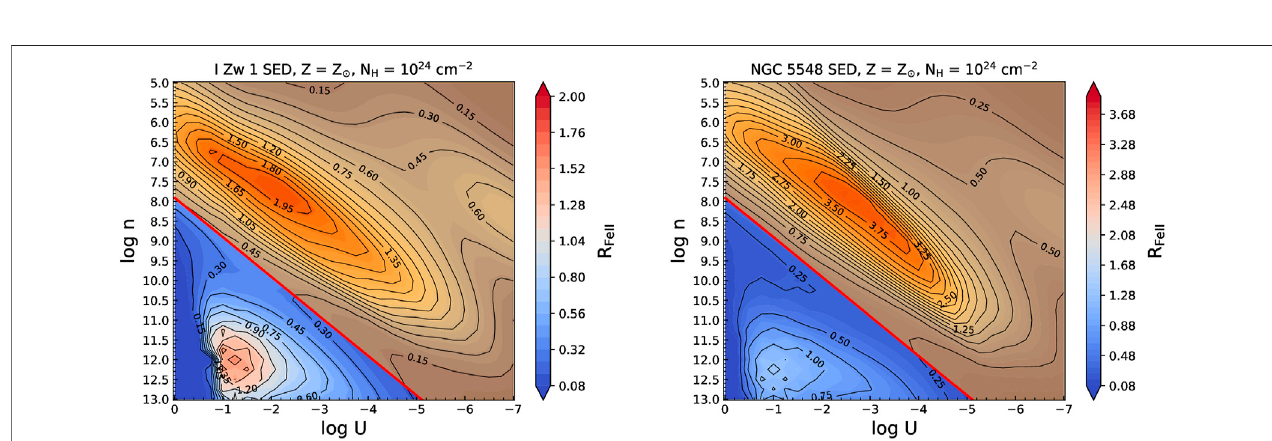
FIGURE 3 | log U − log n H 2D histograms color-weighted by R FeII . Remaining labels and parameters shown here are identical to Figure 2 .